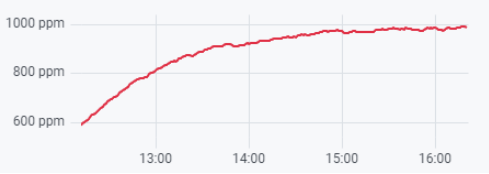
Figure 4. CO 2 concentration trend in the bedroom.